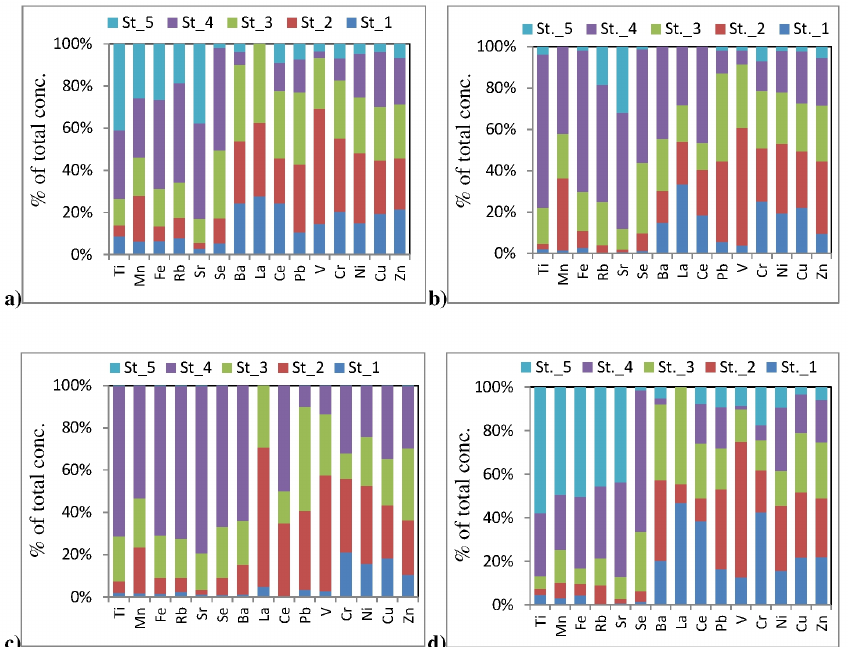
Fig. 4. Distribution of investigated elements according to their size fractions for all four air mass directions: (a) AM, (b) MC, (c) ME, and (d)